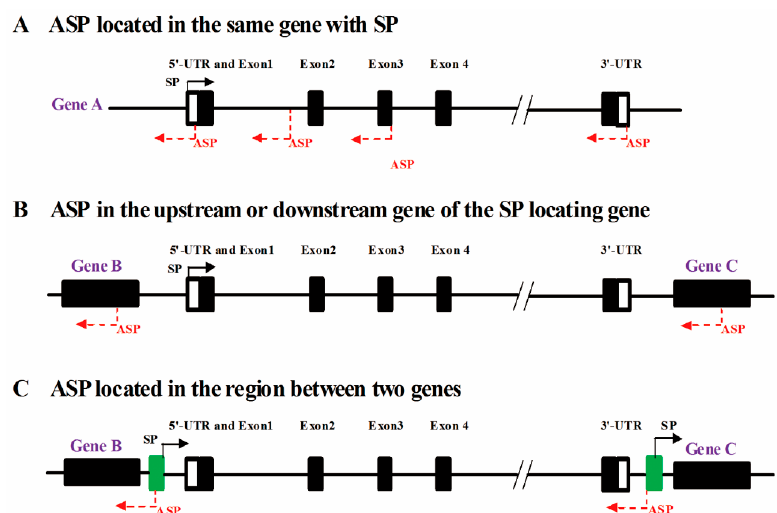
Figure 1. Characteristics of the locations of antisense promoters (ASPs). When an ASP (red reverse dotted arrow) and the sense promoter (SP) (black solid arrow) are located in the same gene ( A ); the ASP can be located at any position in the 5 ′ -UTR, exons and introns or 3 ′ -UTR. ASPs can also be located in genes upstream or downstream (gene B or C, respectively) of the SP gene ( B ); or an ASP may be located between two genes, with SP in the same region (green rectangle) ( C ). In the figure, “/ /” indicates other exons and introns.